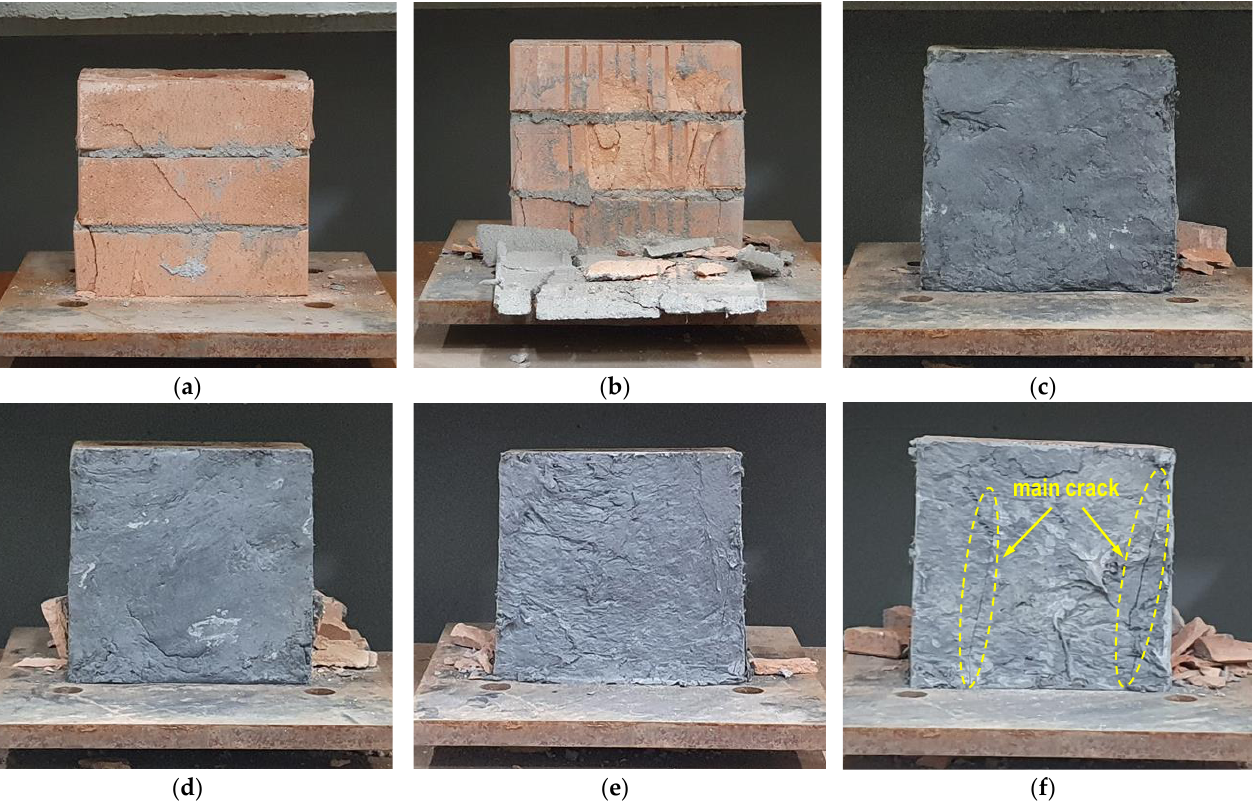
Figure 4. Failure mode for compressive strength test: ( a ) CR #1; ( b ) CM10 #1; ( c ) CH10 #1; ( d ) CH20 #1; ( e ) CH30 #1; ( f ) CH30 #3.